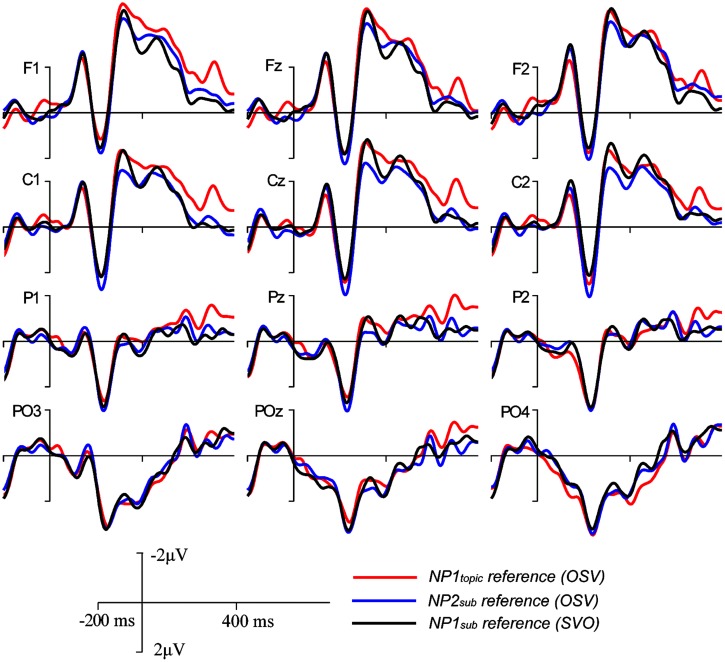
Grand average ERPs time-locked to the critical pronoun in Experiment 2 for the NP1topic reference (OSV structure), the NP2sub reference (OSV structure), and the NP1sub reference (SVO structure), respectively.